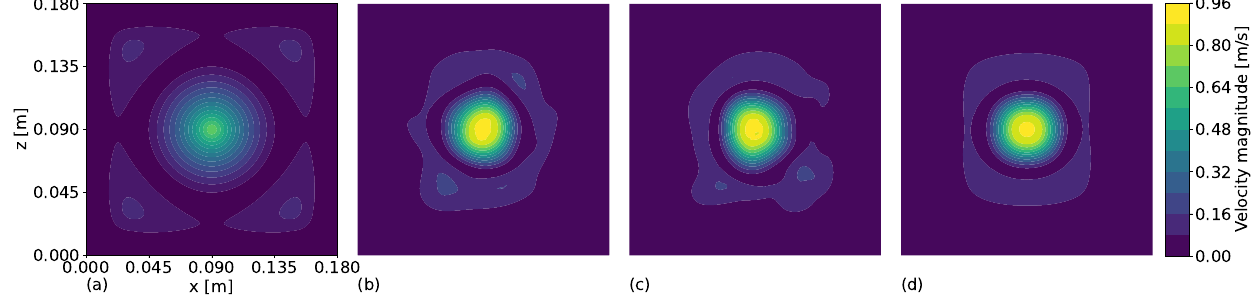
Figure 12. Velocity magnitude field at HA1. ( a ) k − ε model; steady-state; ( b ) LES model at t 1 = 205 s; ( c ) LES model at t 2 = 1096 s; ( d ) LES model;